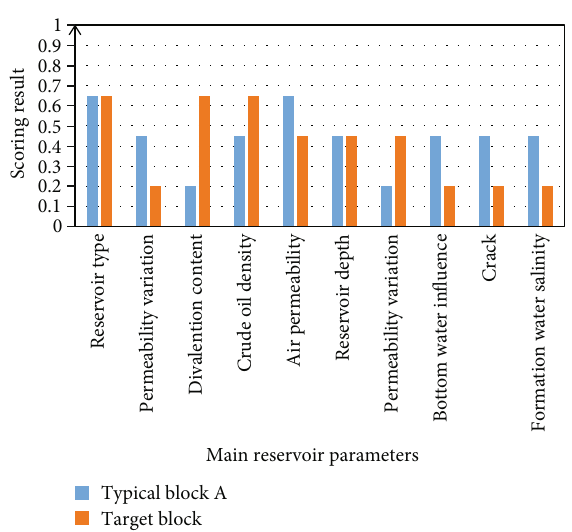
Figure 3: Scoring results of main reservoir parameters of target block and typical block A under polymer fl ooding mode.